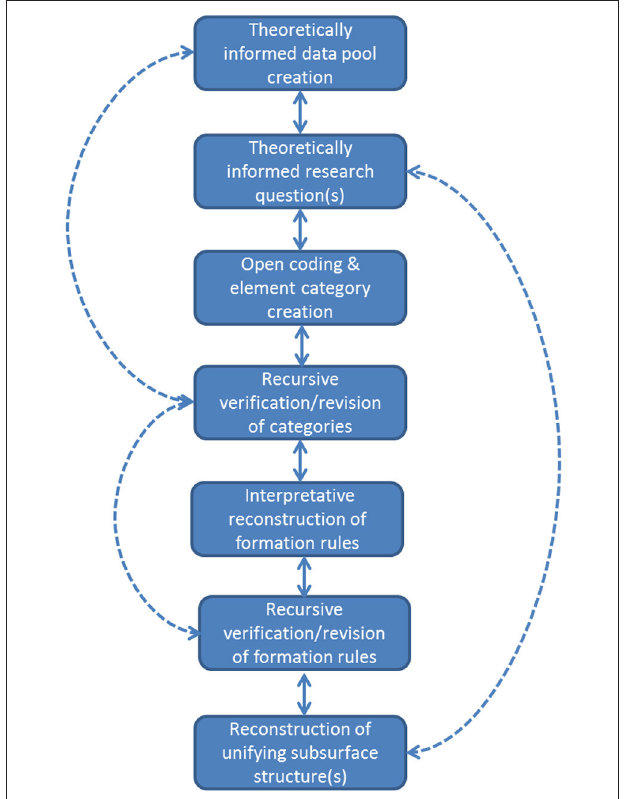
FIGURE 1 | Iterative analytical approach (Boettcher,